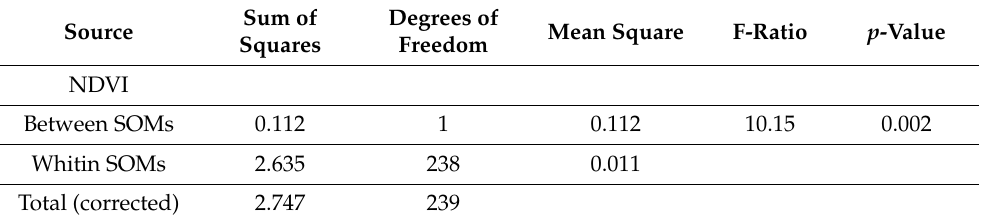
Table 6. Analysis of variance (ANOVA) of NDVI for the two sampling sites SOM5 and SOM15 using the average index value of the plots for each sensing date range between March and June from 2000 to